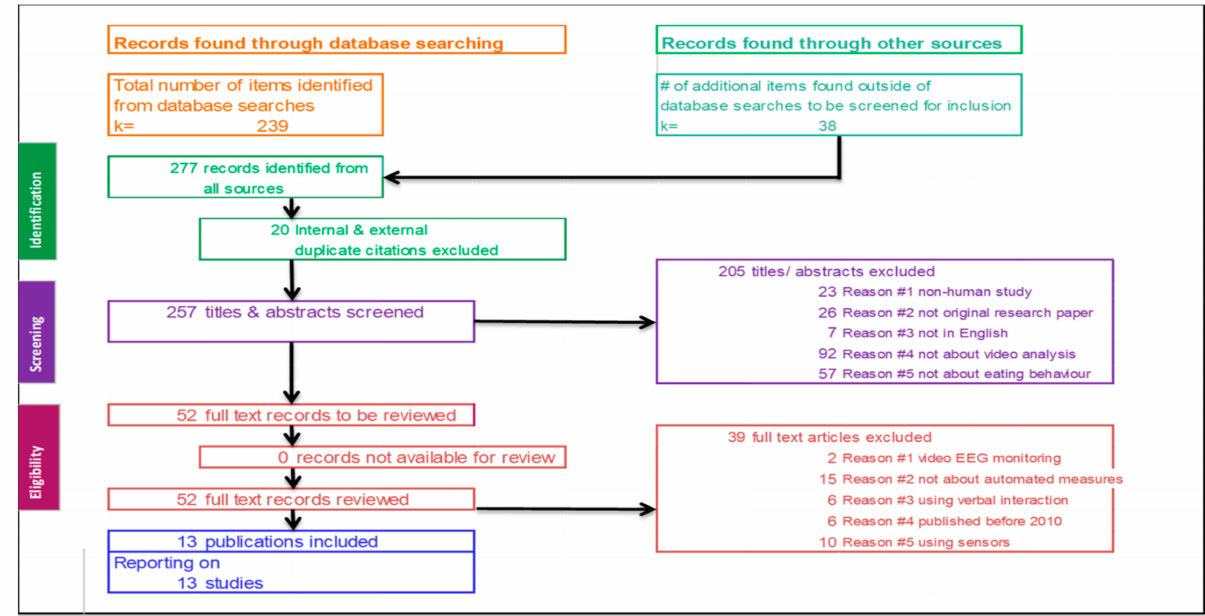
Figure A1. PRISMA flow diagram that depicts the identification, screening, and eligibility workflow for including the scientific records in this